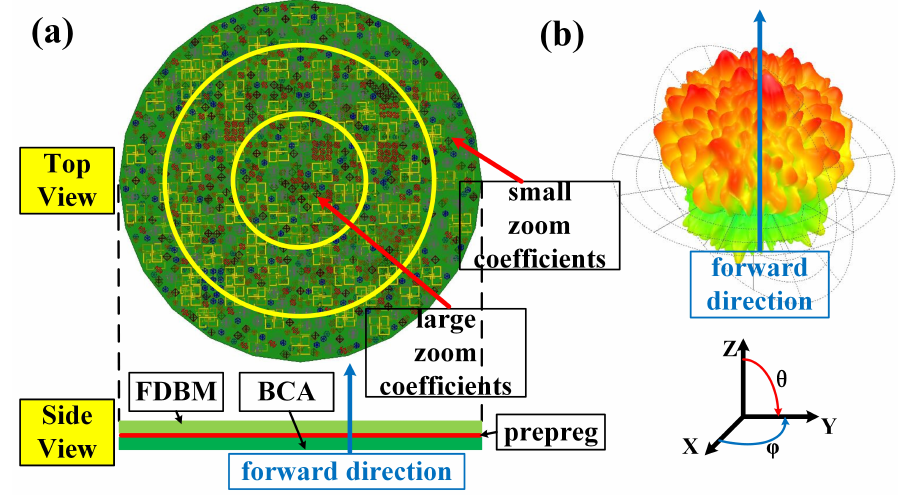
Figure 3. ( a ) The schematic of the bunching metamaterial antenna (BMA); ( b ) radiation pattern of the BMA at 34 GHz. FDBM, frequency-diverse bunching